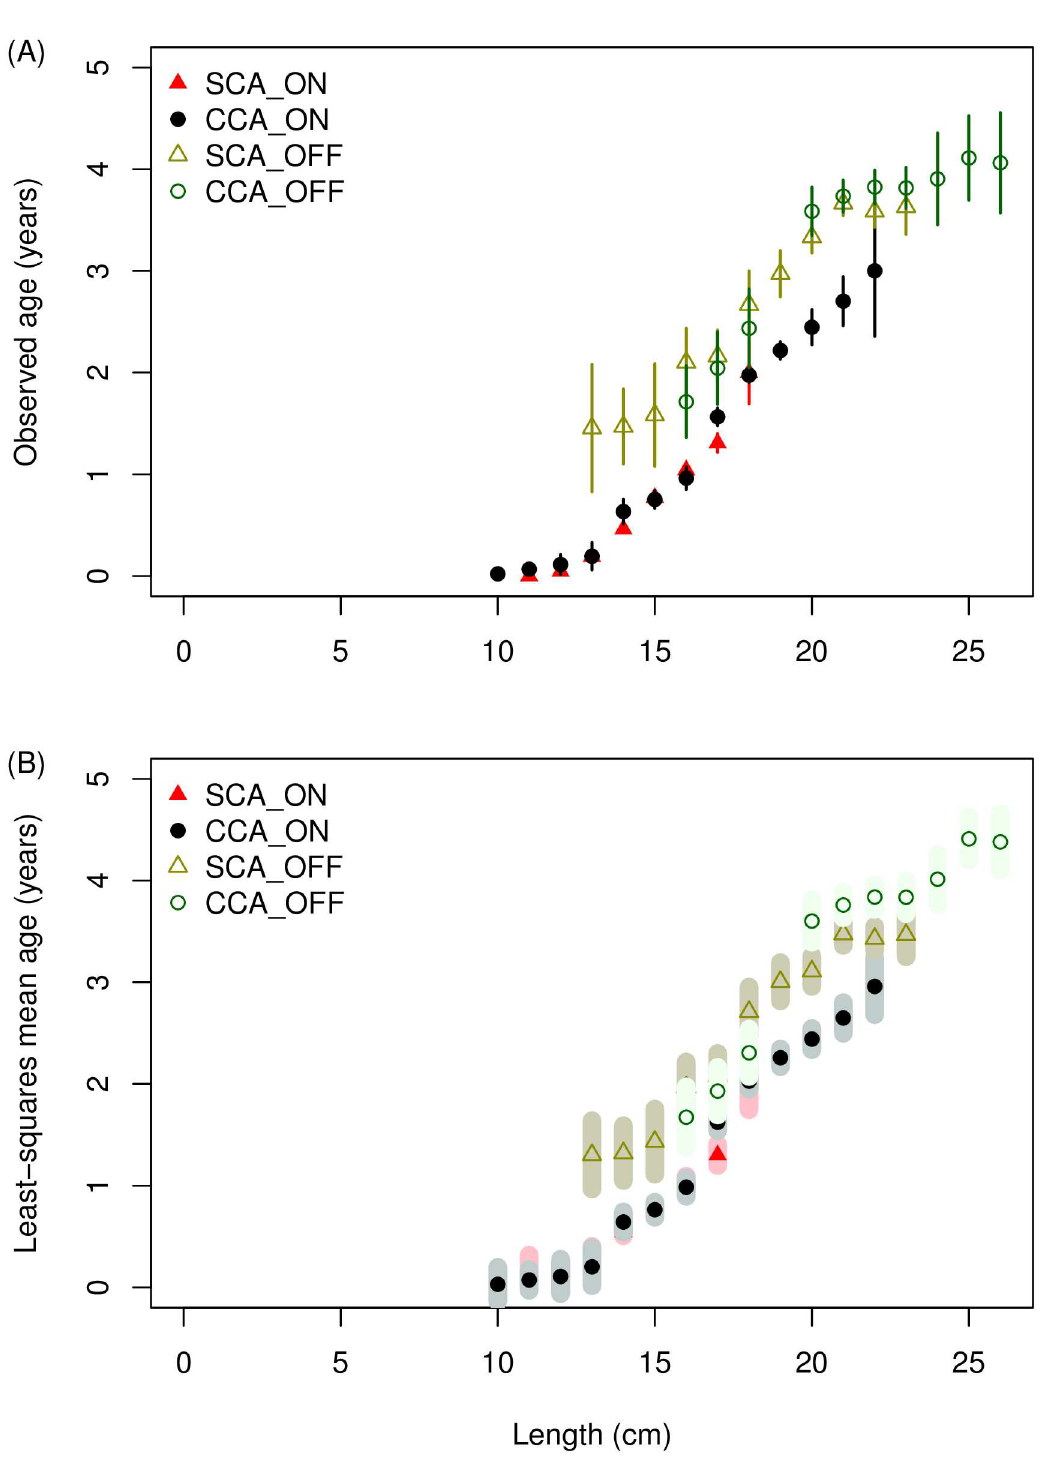
Fig 5. Observed mean age-at-length and least-squares mean age-at-length for quarter 2 (April-June), 2004– 2010. (A) Observed mean age-at-length; and (B) least-squares mean age-at-length from the spawningareas of Southern California onshore( ▲ ), SouthernCaliforniaoffshore ( Δ ), central Californiaonshore( ● ) and central California offshore ( ○ ), where the error bars in the upper panel indicatethe 95% confidenceintervals of the observations and shadedareas in the bottom panel represent95% confidenceintervals of the